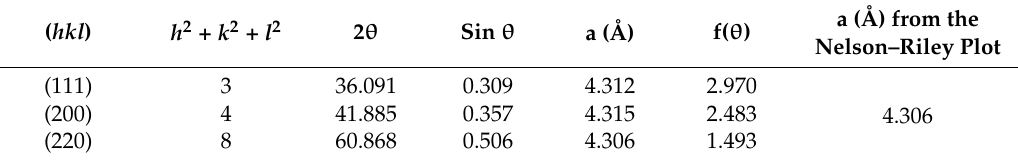
Table 3. Structural parameters of TiC in nanocomposite B with 20 vol % TiC sintered at 900 ◦ C.